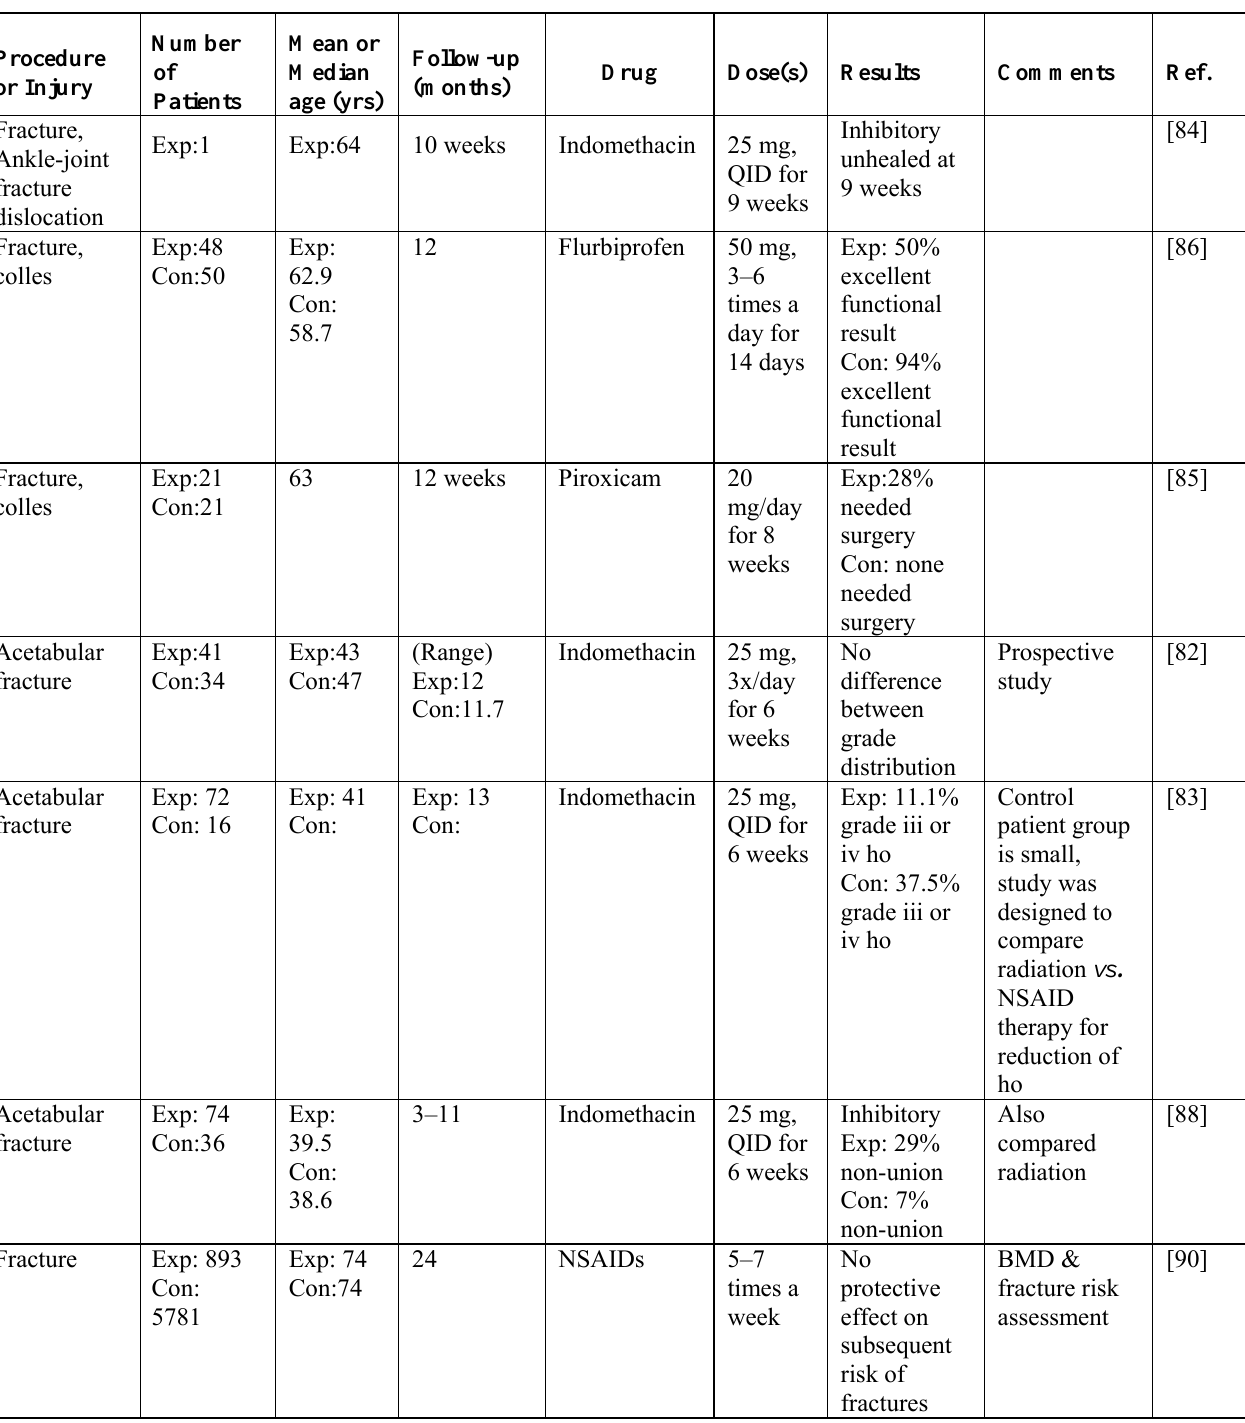
Table 2. NSAID effects on bone healing: human